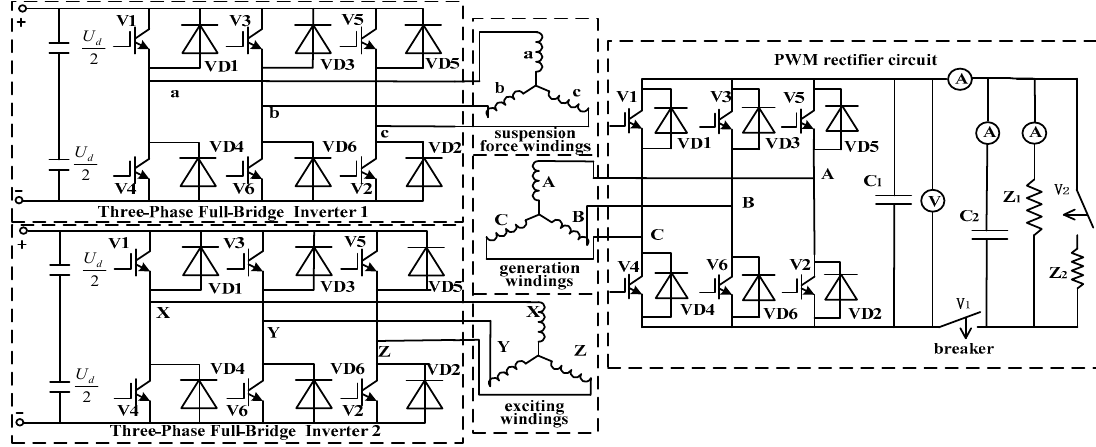
Figure 3. The external circuit of HEBPMG.